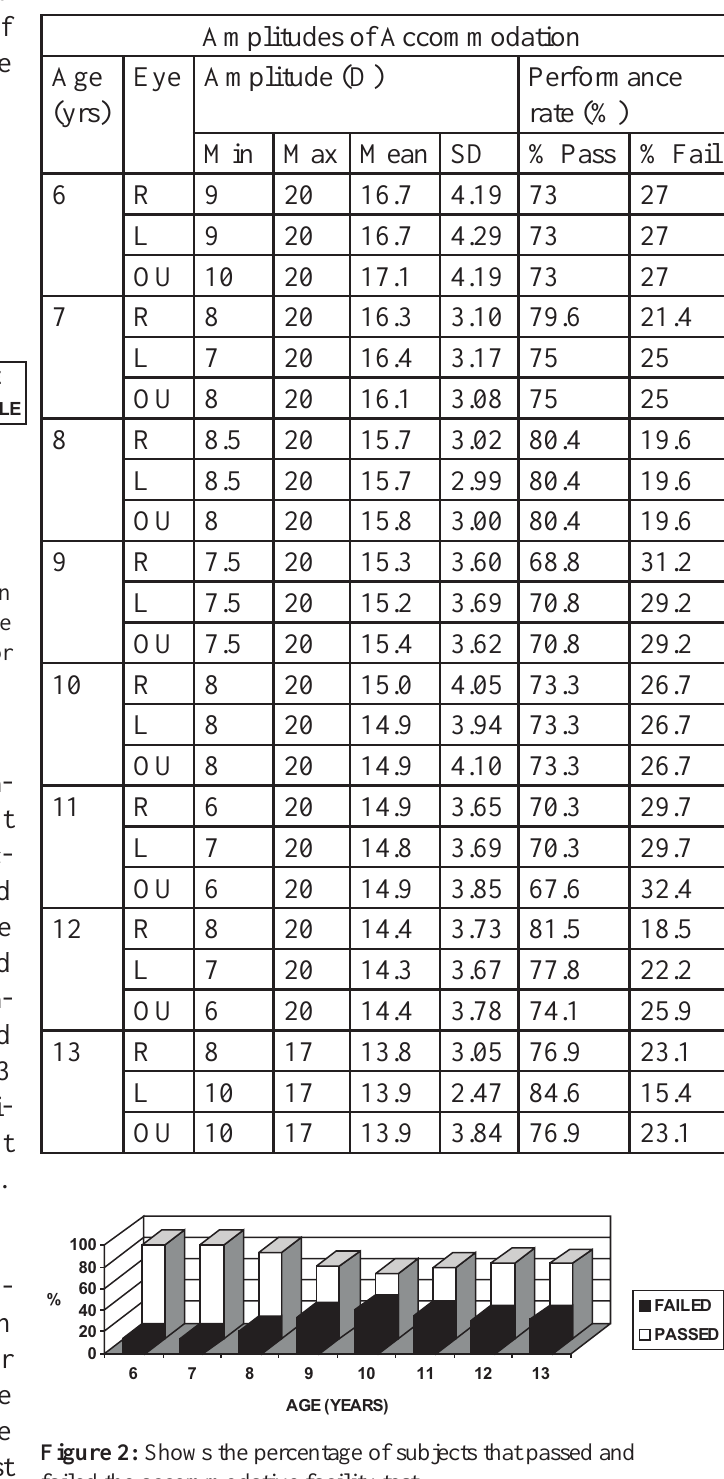
Table 1: shows the minimum, maximum and mean amplitudes as well as the percentage of children who passed or failed the amplitude test for the right eye, left eye and binocularly.